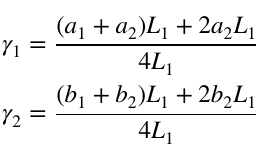
Fig. 10 Membership functions for multiple input fuzzy sets with 0 < 𝜃 0.5 1 ∕ 𝜃 2 <